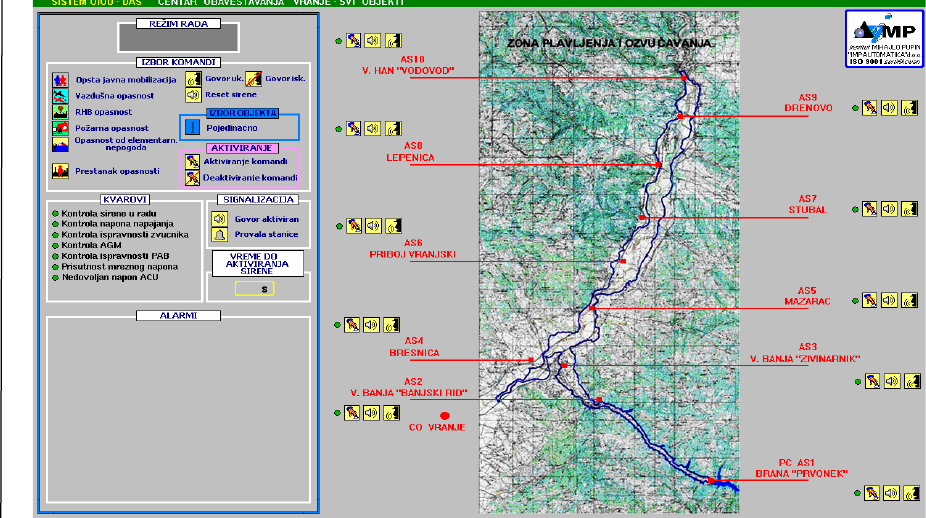
Ovaj modernizovani sistem ve ć je instaliran na nekoliko objekata (HE Bajina Bašta, brana Rovni-Valjevo, brana Prvonek kod Vranja), gde je poka- zao visoku efikasnost (slika 2).